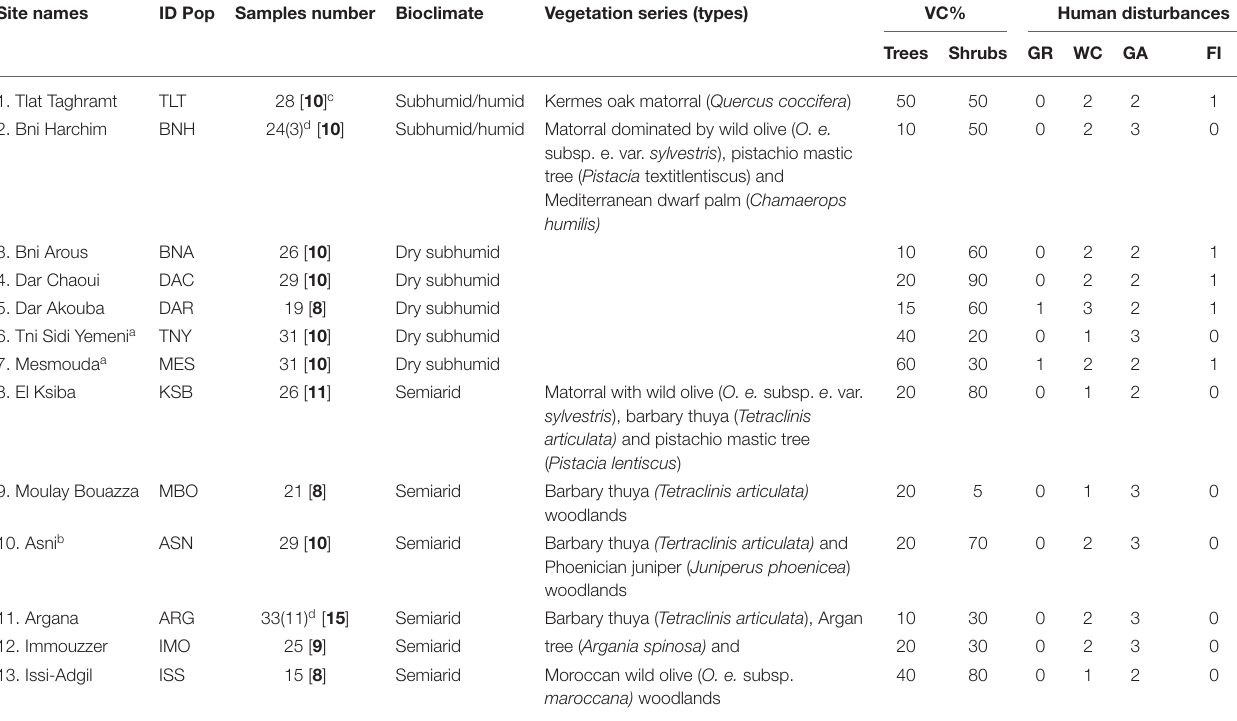
TABLE 2 | Number of samples analyzed and main ecological features per